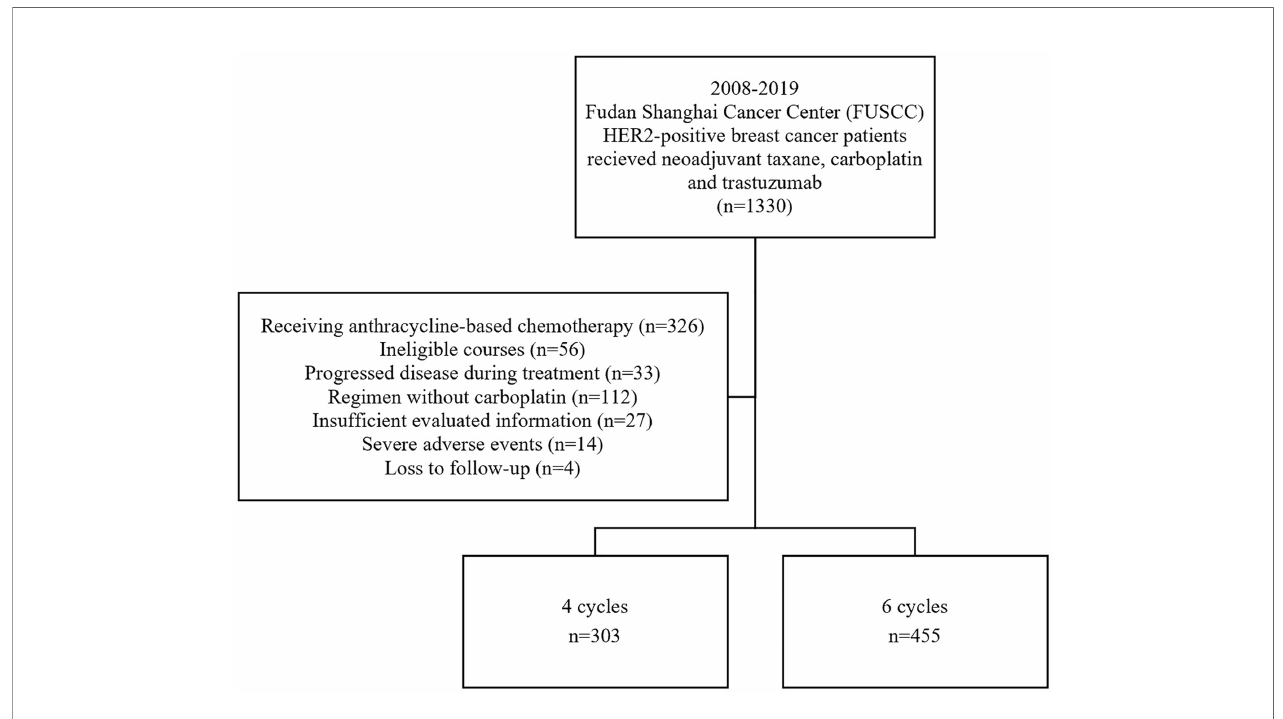
FIGURE 1 | Flow chart of patient